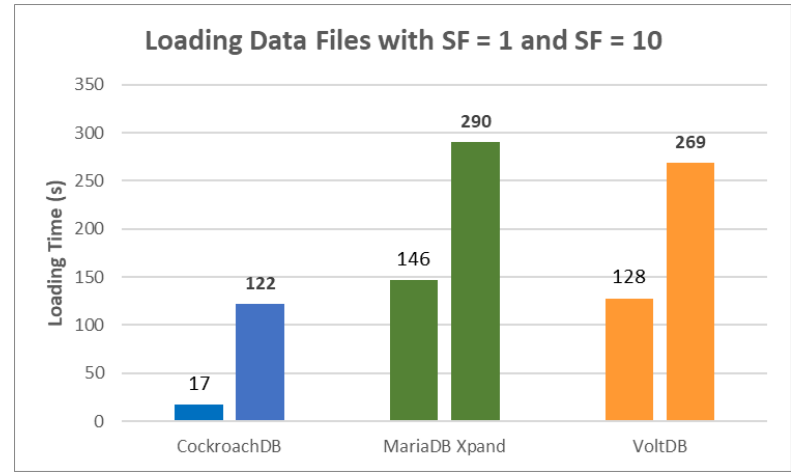
Figure 7. Results for loading data files with SF = 1 and SF = 10.